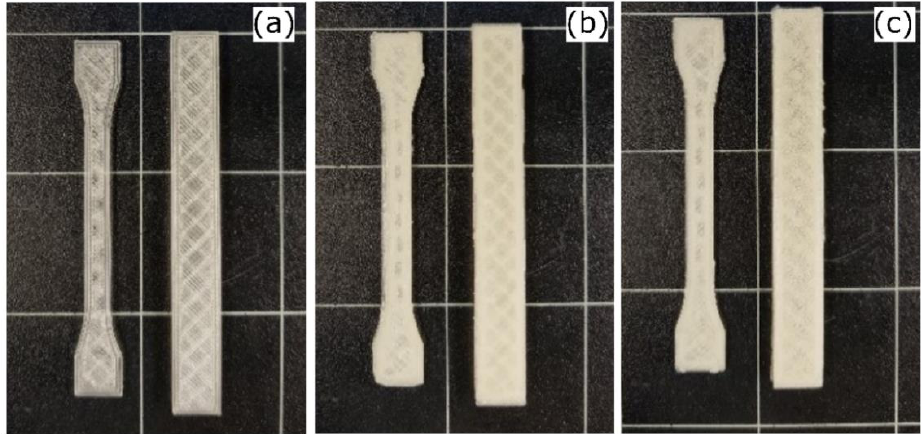
Figure 3. Test specimens of ( a ) PLA-0%, ( b ) PLA-3%, and ( c ) PLA-5%CaCO 3.